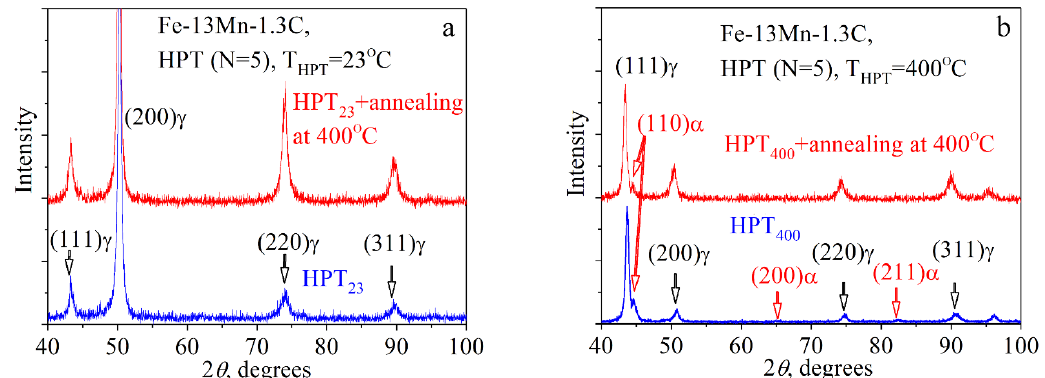
Figure 6. The e ff ect of HPT-processing temperature and subsequent annealing at 400 ◦ C on XRD